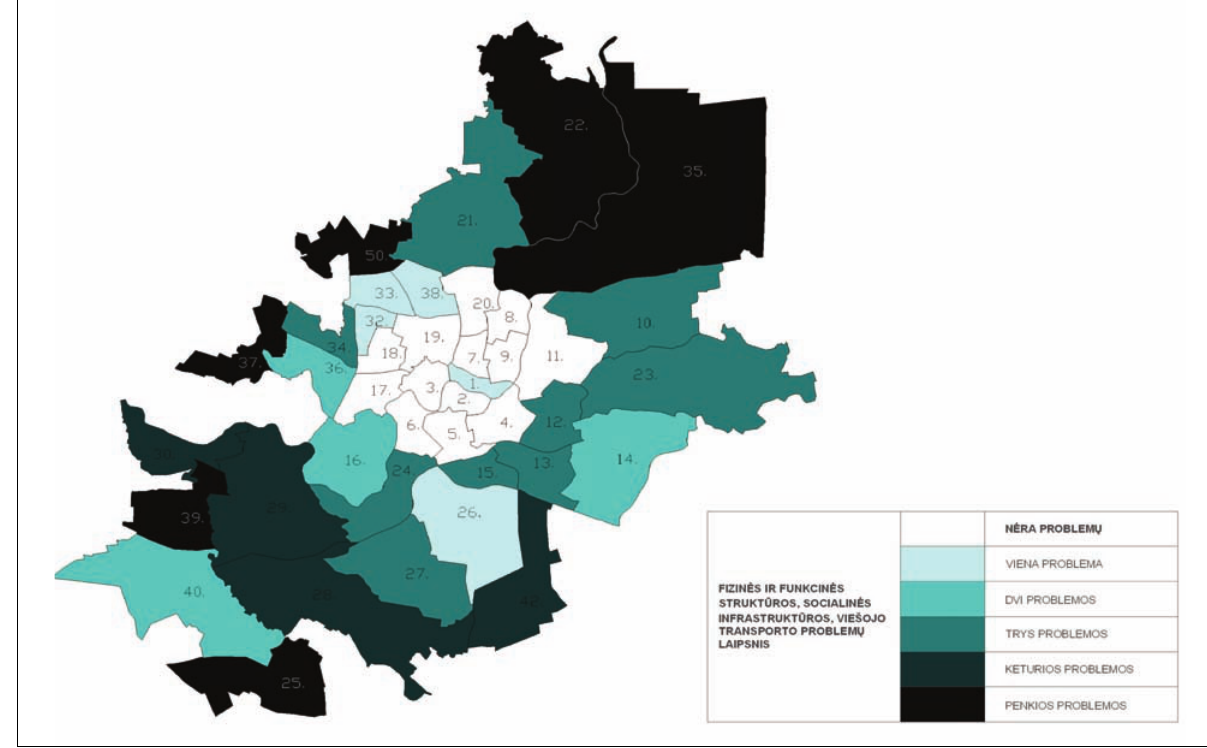
Fig 7. Key problems of Vilnius according to the citizens’ estimation results, 2005